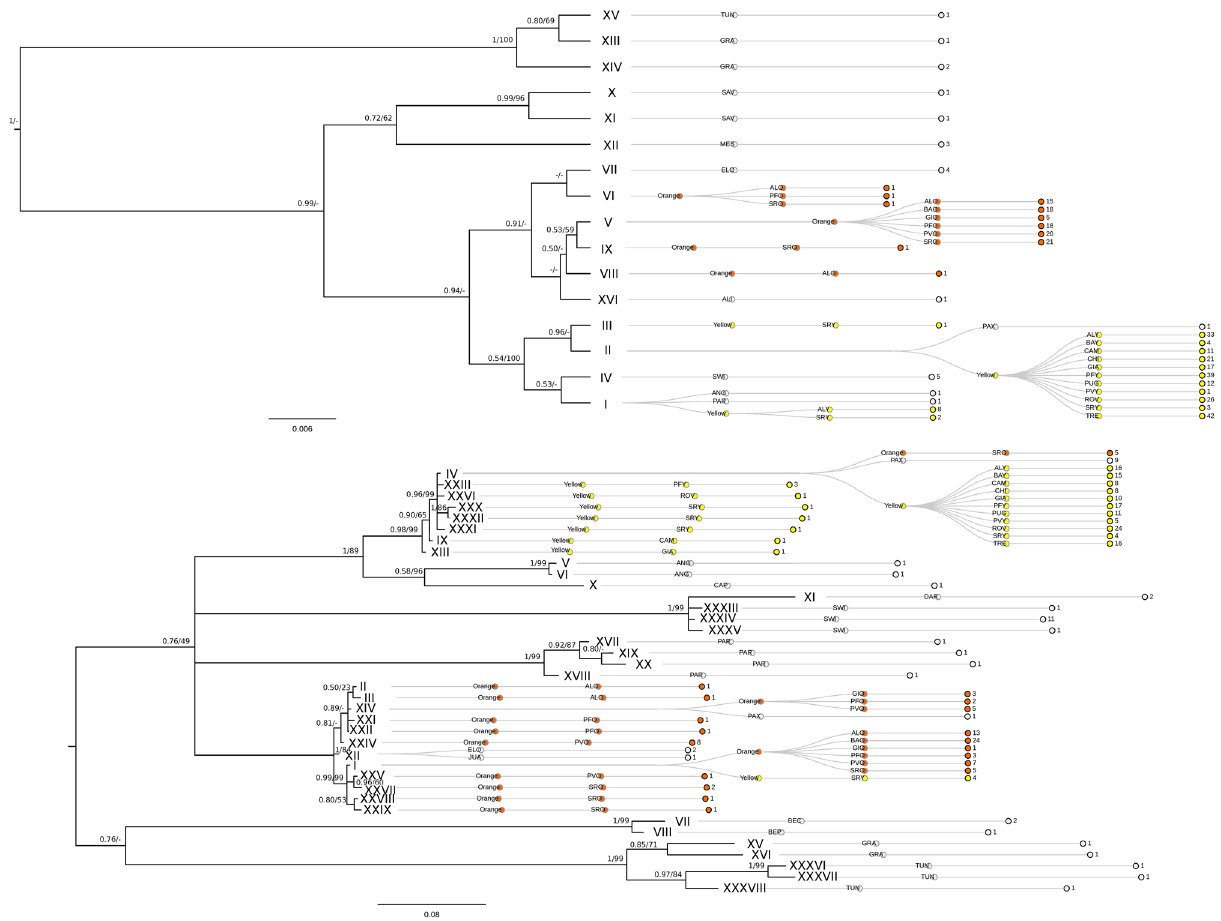
Figure 3. Phylogenetic trees and clustering dendrograms based on COI (above) and ITS (below) gene markers between 16 (COI) and 38 (ITS) haplotypes within Parazoanthidae family, respectively. Identical sequences were dereplicated into haplotypes and are presented on the tree nodes in roman numerals. For ITS the phylogentic tree using the MAFFT + GBlock alignment is shown. Bayesian posterior probability (on the left) and Maximum Likelihood (ML) bootstrap support based on 1,000 iterations (on the right) are shown on tree branches with a cutoff value of p = 50 (%). Inferior support values were considered as unresolved. Clustering dendrograms were reconstructed for each gene marker in RAWGraphs (https ://rawgr aphs.io/) and added as extensions onto tree nodes to further clarify haplotype/sequence assignments. Clustering dendrograms hierarchically consist out of 2 levels for sequences downloaded from GenBank (Species code, Number of sequences) and 3 levels for samples sampled in our study (Morphotype Color, Sampling Location, Number of sequences). Sequences originating from our samples are colored in yellow and orange for “Slender” and “Stocky” morphotypes, respectively, while all sequences downloaded from GenBank are in grey. Codes are as follows for Parazoanthus sp. sequences